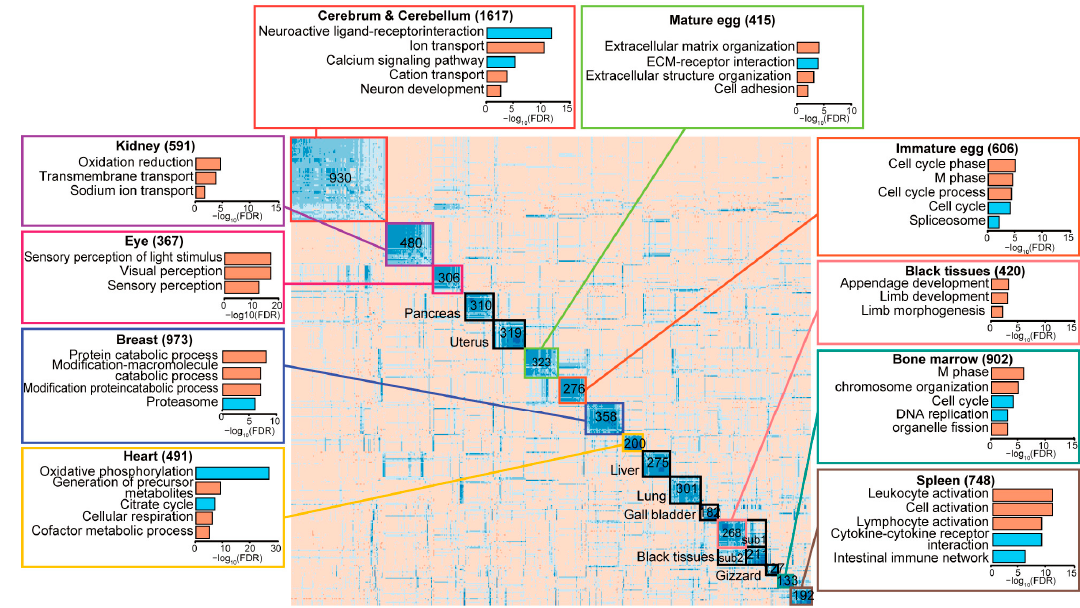
Figure 2. Co-expression clusters of lncRNAs across 20 tissues based on Pearson’s correlation coefficient metrics using ‘rsgcc’ package in R and functional annotations (see the “Clustering of co-expressed lncRNAs” section in the Methods for more details). Co-expression clustering of lncRNAs across 20 tissues defines 16 clusters and two sub-clusters specific to a tissue or a set of similar tissues. The boxes outlined in a color indicate those with significant gene ontology (GO) biological processes (orange bars) or Kyoto Encyclopedia of Genes and Genomes (KEGG) pathway terms (cyan bars) associated with protein-coding genes co-expressed with lncRNAs in the respective cluster. The significant enrichment of terms was tested using the hypergeometric test and adjusted by the FDR, indicated using a logarithmic scale on the X -axis in the box. Clusters outlined in black are those with neither a significant association with a GO term nor any co-expressed protein-coding genes. Sub-clusters in the clusters are indicated where appropriate. The number in each cluster indicates the number of lncRNAs in the cluster and the number in the boxes with functional terms indicates the number of co-expressed protein-coding